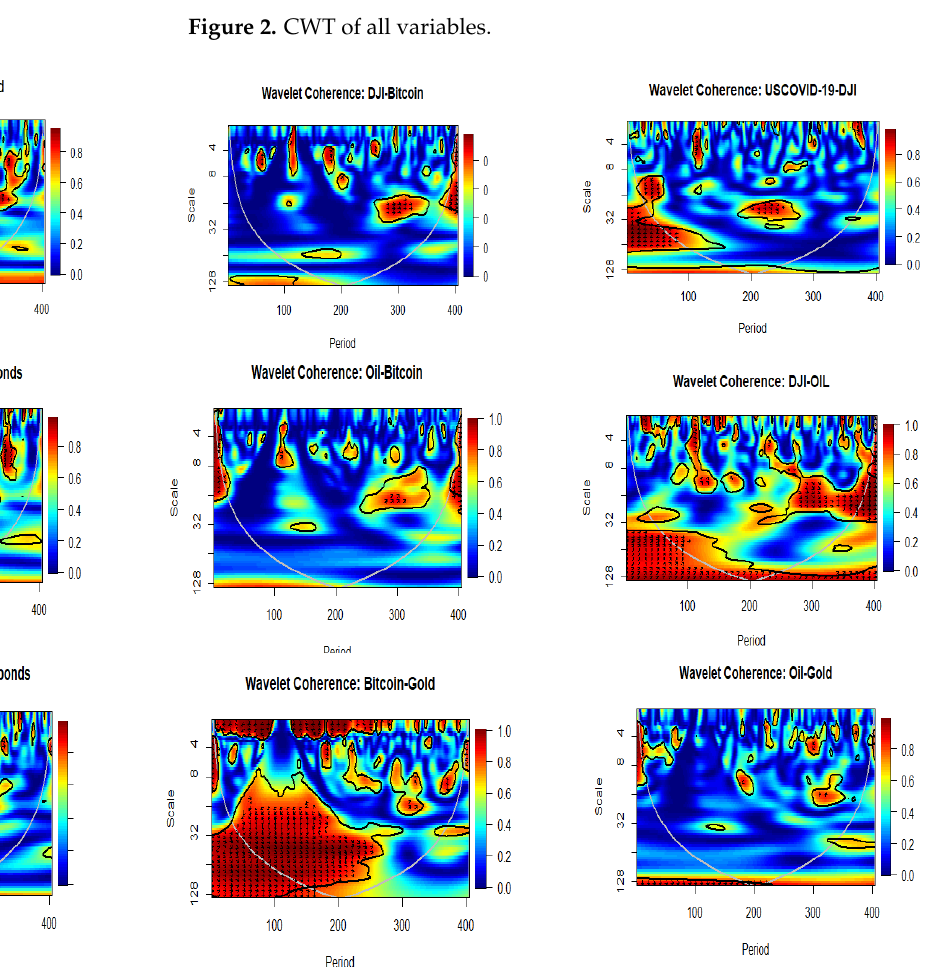
Figure 2. CWT of all variables.